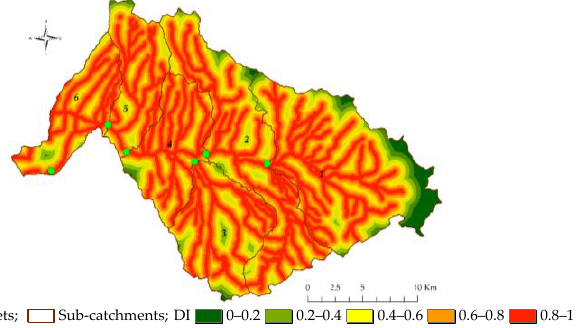
Figure 11. Geographical distribution of distance indicator (DI) classes in the Rocha River catchment (both 1997 and 2017). Areas with the highest DI values (Figure 11) dominated the study catchment, with distances below 520 m (Table 5). Similar results were found in all sub-catchments, but all DI classes (distances longer than 2166 m) were only found in sub-catchment 1.